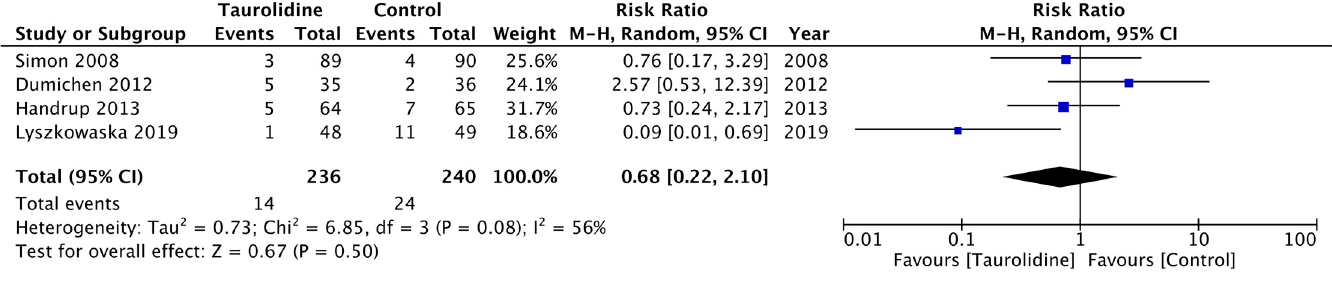
Fig 5. Forest plot of taurolidine versus control for the number of catheters removed due to infection.